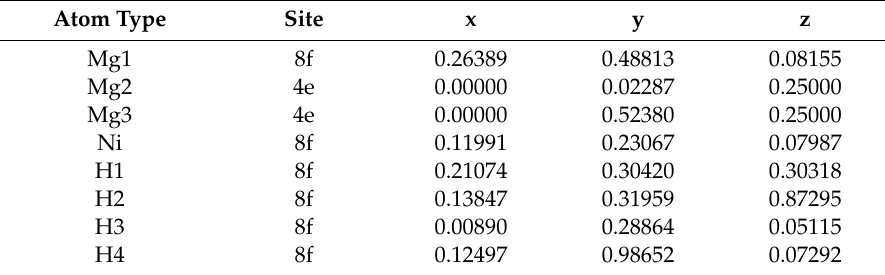
Table 1. Atomic positionsin Mg 2 NiH 4 .